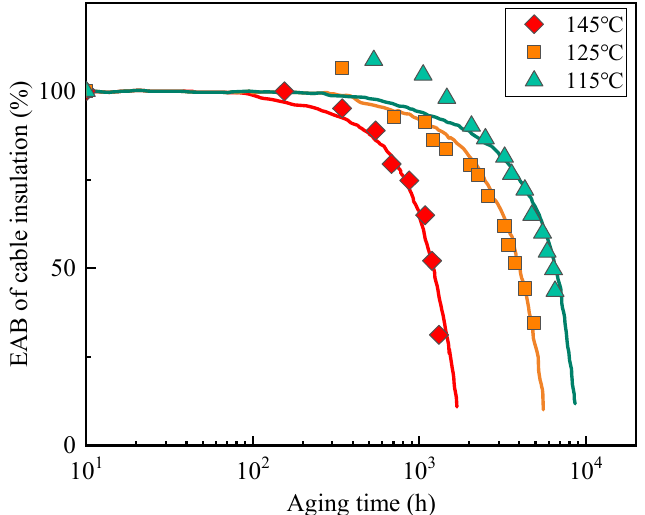
Figure 1. Retention rates of EAB versus aging time at the indicated temperatures for slice samples of XLPE cable insulation and the fitting curves.